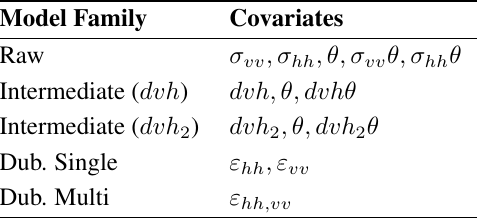
Figure 3. Flow diagram of the statistical model-selection procedure. The best model is first chosen based on its minimal prediction error, then the best model that includes ground-based data is chosen. In the third selection step, the best model across all five families of possible combinations of predictors is identified. In the final selection step, the influence of spatial correlation is considered and the best performing model is identified. Table 3. Table shows the covariates corresponding to every model